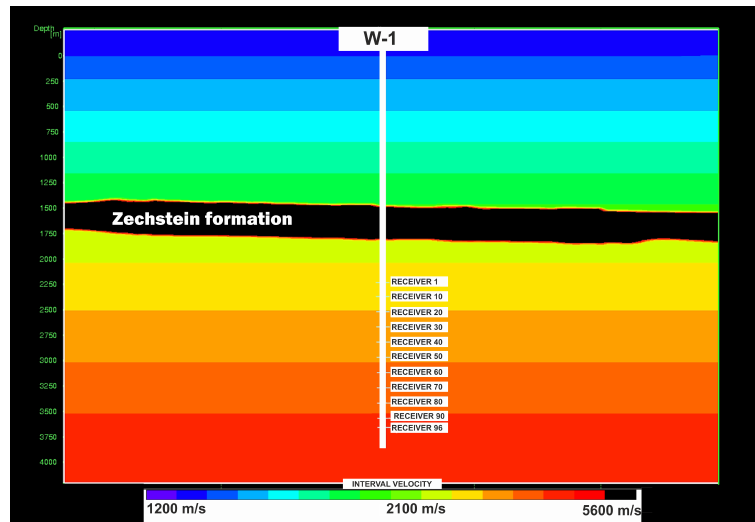
Figure 5. Velocity model for seismic migration requirements, together with the trajectory of well W1 ( white line ) and receivers. The black layer is the Zechstein formation (see in [5]